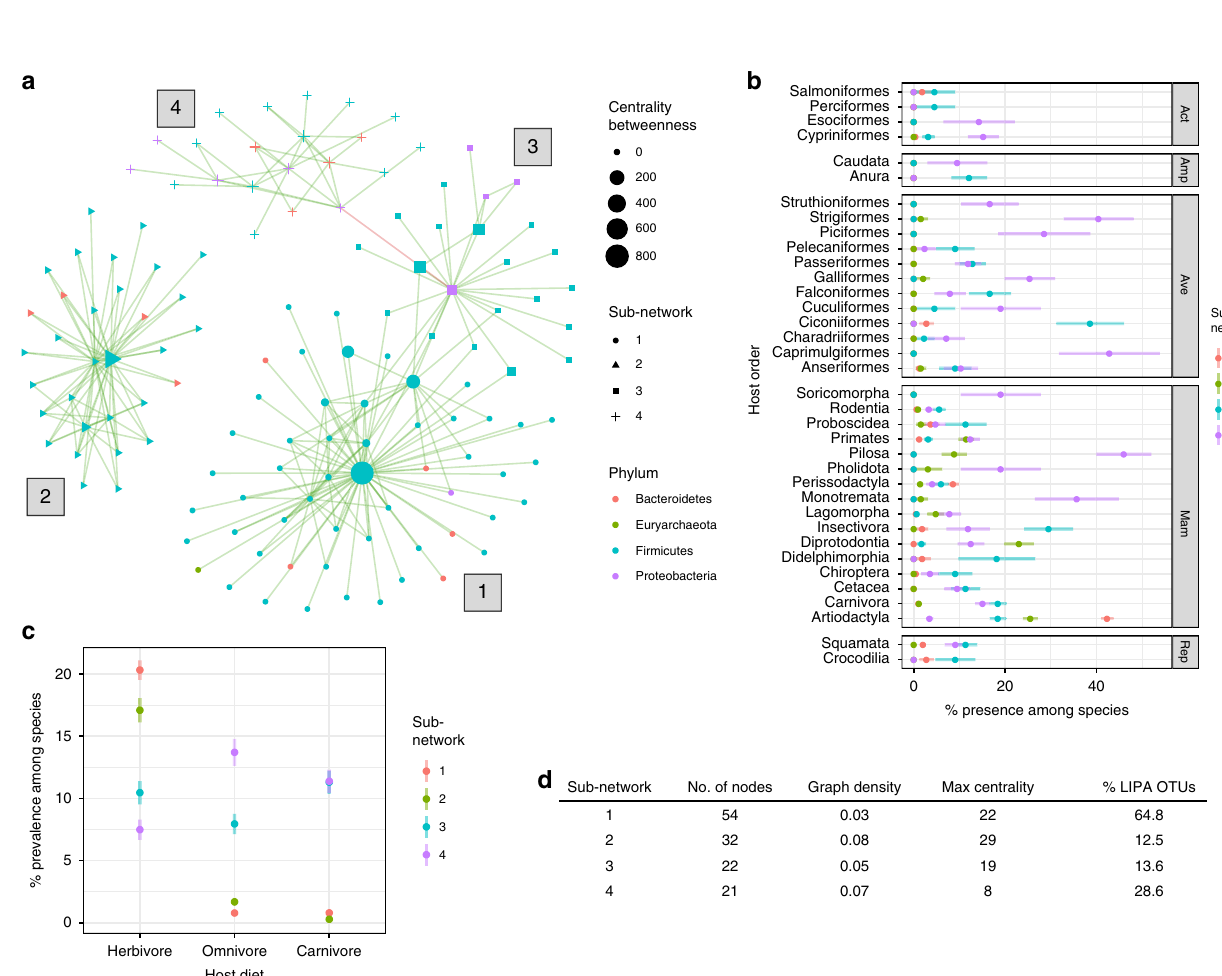
Fig. 7 Co-occurrence analysis revealed four sub-networks of co-occurring operational taxonomic units (OTUs) that differ in taxonomic composition, network structure, and distribution across host taxonomic orders. a The network is a presence – absence co-occurrence network, with only signi fi cant edges shown (see “ Methods ” ). Sub-networks are represented by differing node shapes and labels next to each sub-network. “ Centrality betweenness ” is a measure of how often the shortest path between two nodes transverses through the focal node. b The distribution of community presence among samples from each species (percentage of samples per species) shown for each host taxonomic order, with points representing the mean and line ranges representing + / − the standard error of the mean. The plots are faceted by host taxonomic class (Act = Actinopterygii, Amp = Amphibia, Ave = Aves, Mam = Mammalia, Rep = Reptilia). c Similar to b but grouped by host diet. d A table of sub-network statistics, with “ Graph density ” de fi ned as “ number of edges/total possible edges, ” “ Max centrality ” de fi ned as the max number of shortest paths between any two nodes that cross the focal node, and “ % LIPA OTUs ” de fi ned as the percentage of OTUs with signi fi cant local phylogenetic signal (Fig. 4). Source data are provided as a Source Data fi le